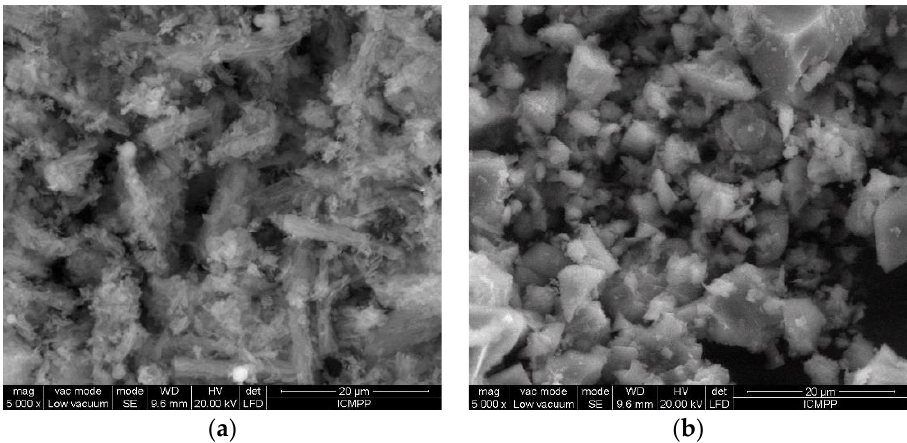
Figure 1. SEM microphotographs of used sorbents ( a ) silica SBA-15 and ( b ) titanosilicate